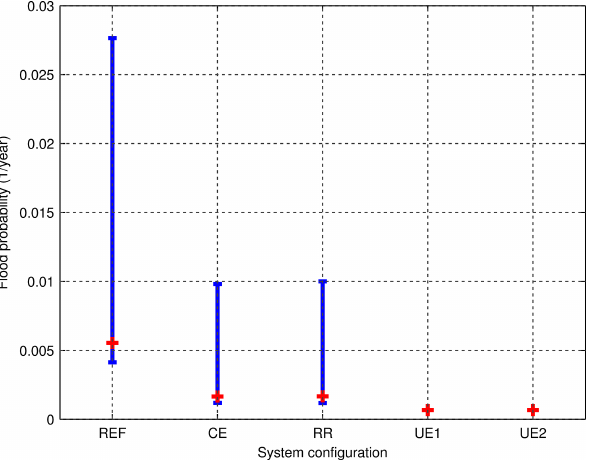
Figure 5. Flood risk of reference system and alternative configura- tions with uncertainty bounds reflecting the different diversion frac- tions. The diamond “WV21” refers to the outcome of a recent policy study (Kind,